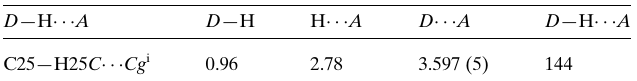
Table 1 Hydrogen-bond geometry (A˚ , (cid:3) ).